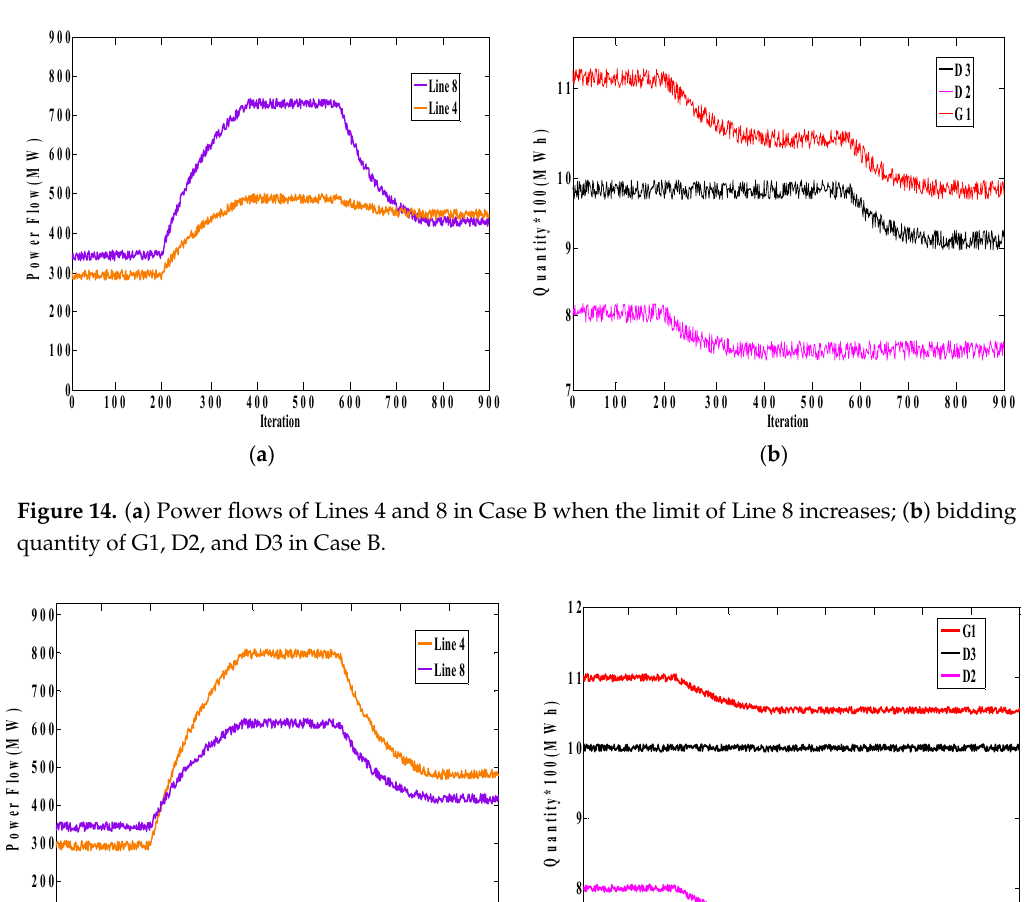
14 of 19 Figure 13. Power flows of Lines 4 and 8 in Case B. Step 1: f max (4) = 500 MW, f max (8) = 800 MW Figure 14 shows the flows of Lines 4 and 8 and the behavior of players in this step. As can be seen, when the limit of Line 8 increases, the behavior of D3 does not change, which means that the decision-making process of D3 does not depend upon the congestion of Line 8. Step 2: f max (4) = 900 MW, f max (8) = 600 MW